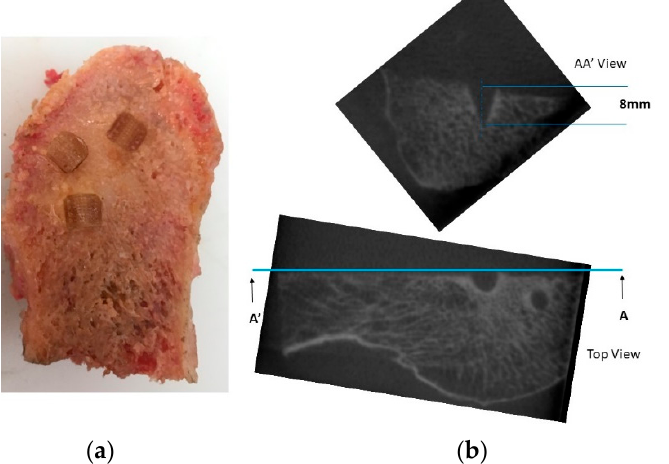
Figure 10. Penetration assay images and fixation of skewers to the bone: ( a ) skewers driven into cancellous bone; ( b ) orthogonal views of the exposure to RX. Top view) Holes formed by the skewers are represented and one of them is sectioned by AA’ cutting plane. AA’ View) Sectional representation that indicates the height of the skewer.